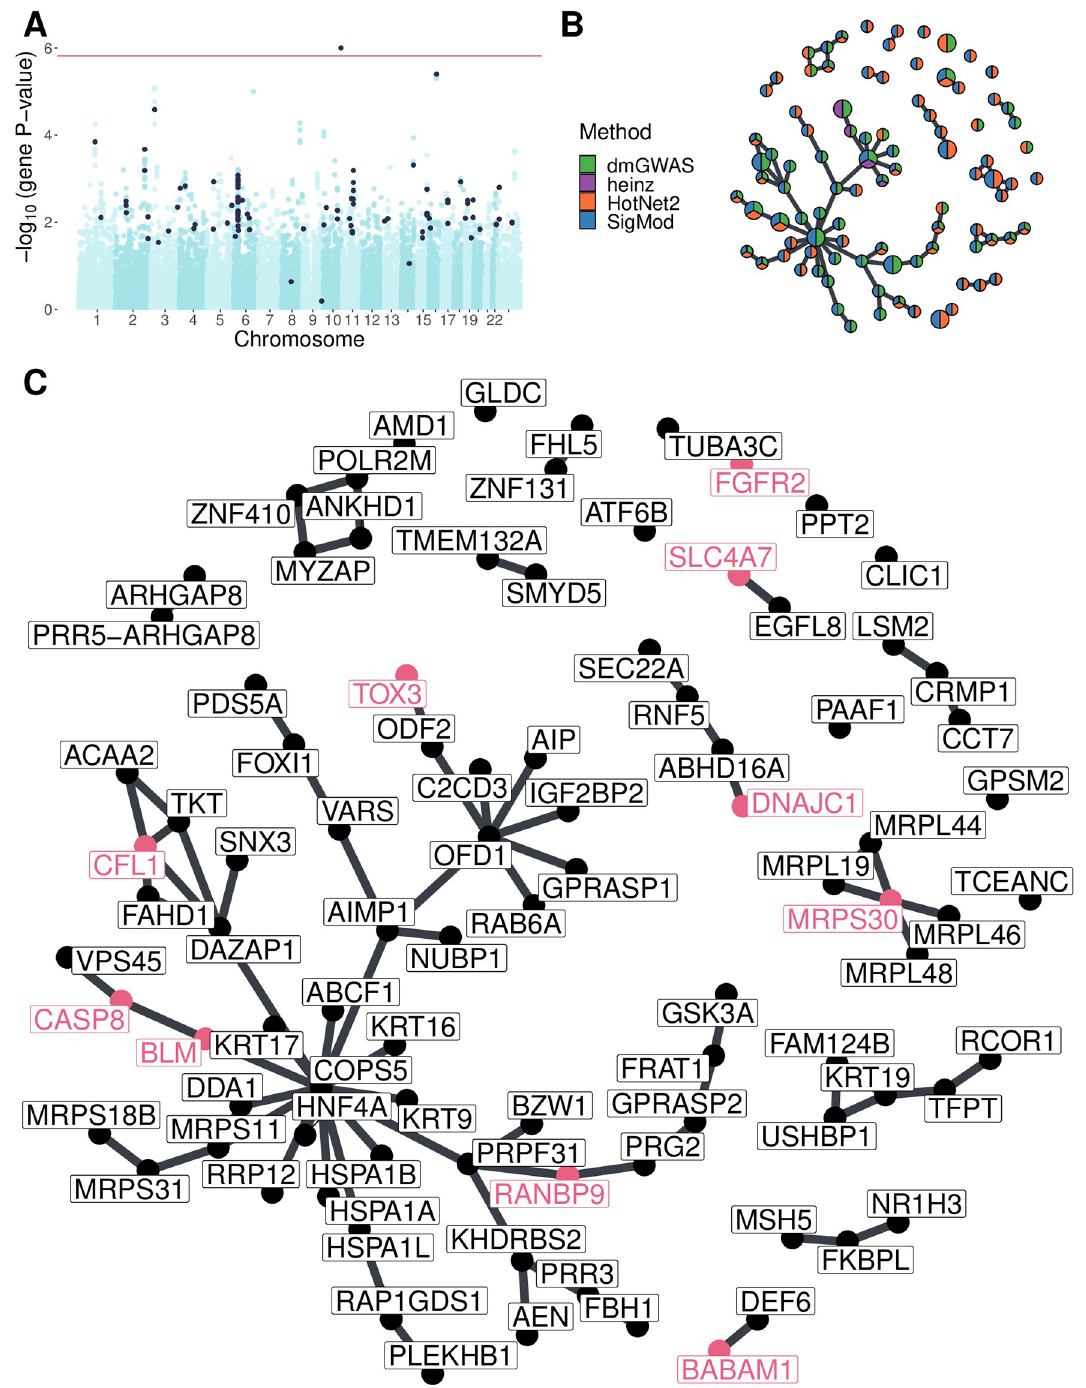
Fig 2. Consensus solution on GENESIS (Section 2.3.3). (A) Manhattan plot of genes; in black, the ones in the consensus solution. The red line indicates the Bonferroni threshold (1.53 × 10 -6 for genes). (B) Consensus network. Each gene is represented by a pie chart, which shows the methods that selected it. We enlarged the two most central genes ( COPS5 and OFD1 ), the known breast cancer susceptibility genes, and the BCAC-significant genes (Section 2.6). (C) The nodes are in the same disposition as in panel B, but we indicated every gene name. We colored in pink the names of known breast cancer susceptibility genes and BCAC-significant genes.